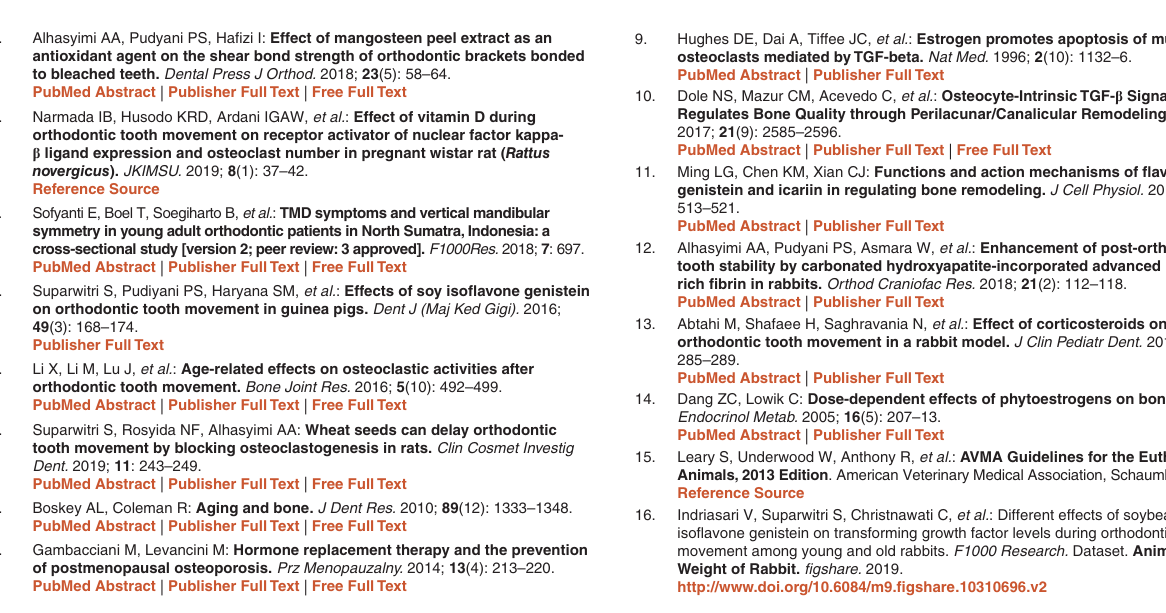
Figshare: Raw Data TGF beta isoflavone genistein. https://doi. org/10.6084/m9.figshare.10116704 17